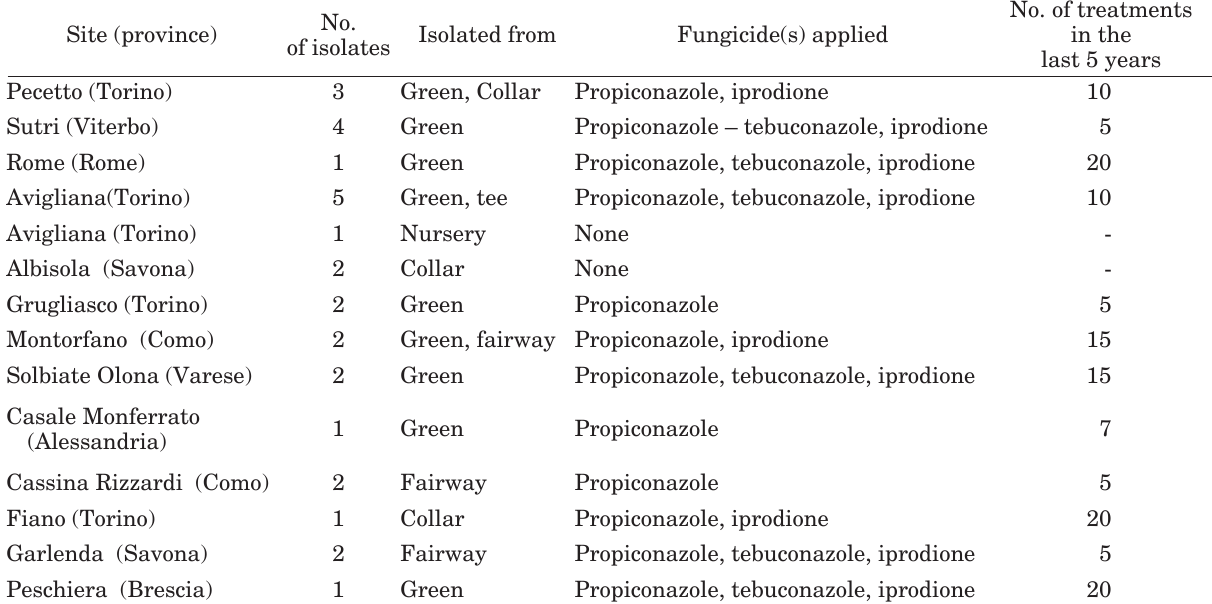
Table 1. Locations, golf course surfaces and fungicides usage at sites where Sclerotinia homoeocarpa isolates were